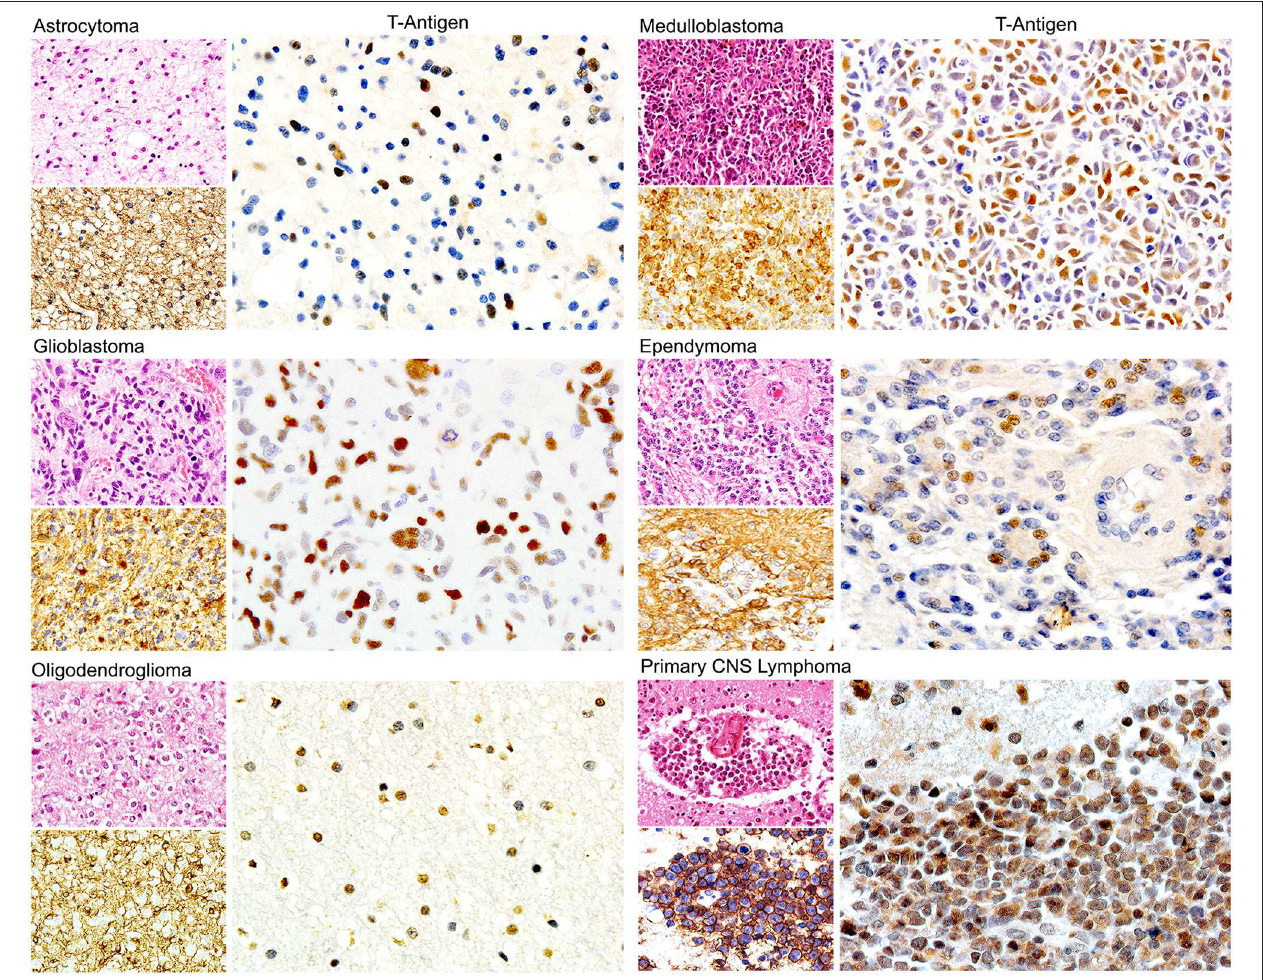
FIGURE 4 | Expression of JCPyV T-Antigen in human brain tumors. Immunohistochemical studies have demonstrated the expression of the viral oncoprotein in a wide variety of astrocytoma, oligodendroglioma, ependymoma to Glioblastoma. Other tumors derived from the neural crest, such as medulloblastomas are also positive. Interestingly, primary CNS lymphomas are also positive. Expression of T-Antigen is nuclear, and interestingly not all neoplastic cells are positive. An example of each of these tumors is shown, with their Hematoxylin and Eosin and specific marker, which for glial tumors is GFAP, for medulloblastomas is synaptophysin and for CNS lymphomas is CD20. (All panels original magnification is